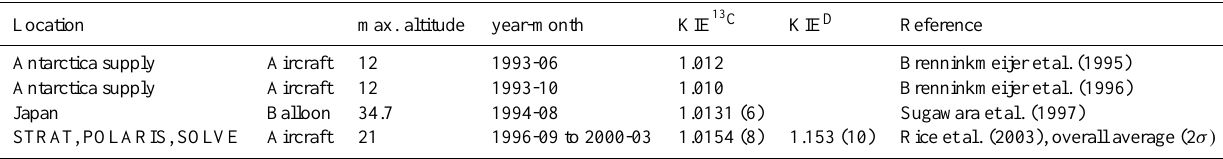
Table 4. Previously published mean KIE values. Location